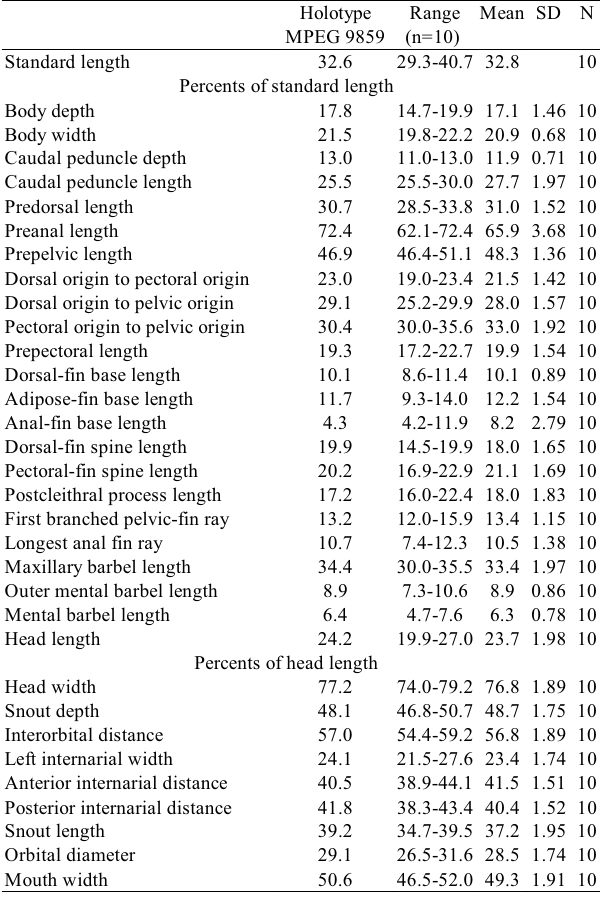
Table 5. Morphometric data for Tatia caxiuanensis . SD = stan- dard